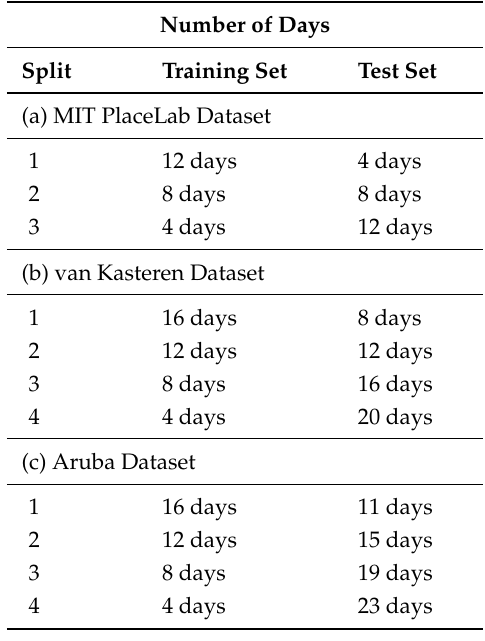
Table 3. Different training splits on (a) MIT PlaceLab, (b) van Kasteren and (c) Aruba datasets. Number of